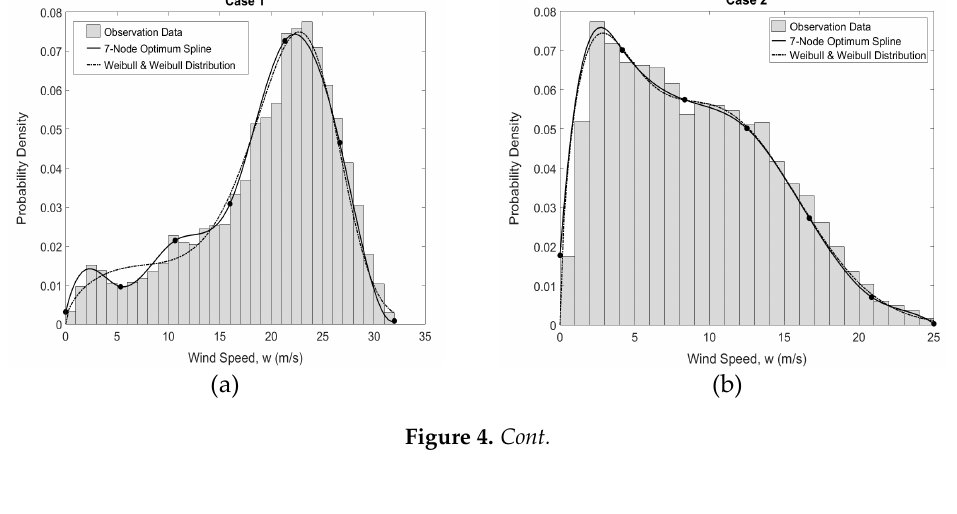
Figure 3. Comparison of the spline-based and Weibull fits with the observed data. ( a ) Multimodal distribution 1; ( b ) Multimodal distribution 2; ( c ) Unimodal distribution; ( d ) Multimodal distribution 3.